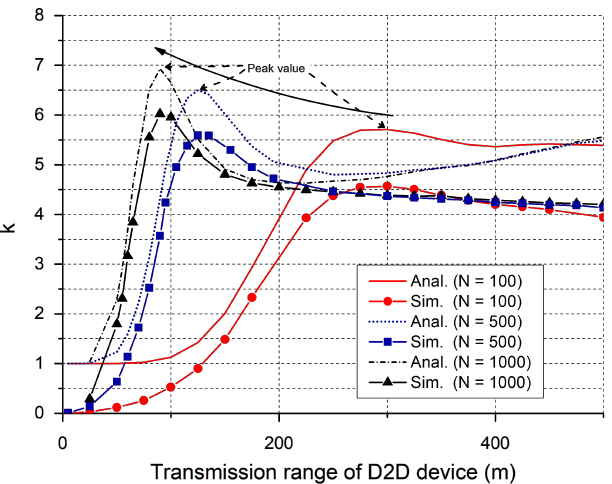
Figure 6. Minimum value of k required to achieve the same message delivery ratio as the epidemic routing protocol. Sim,